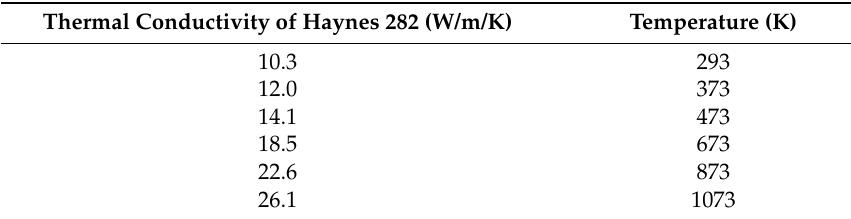
Table 6. Temperature dependence of thermal conductivity [19].